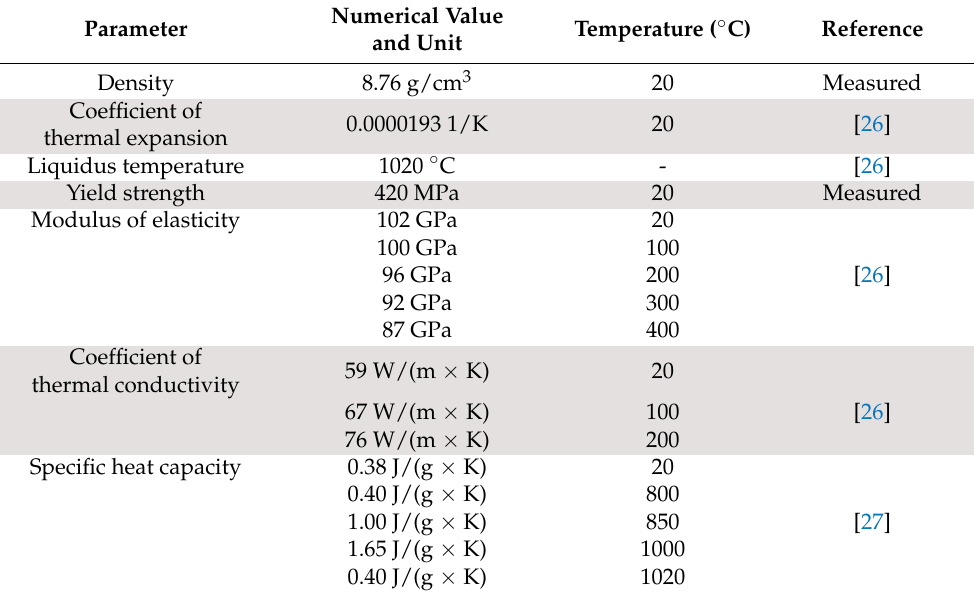
Figure 5. Produced distortion bridge on the building panel. Table 2. Parameters used for developing the simulation